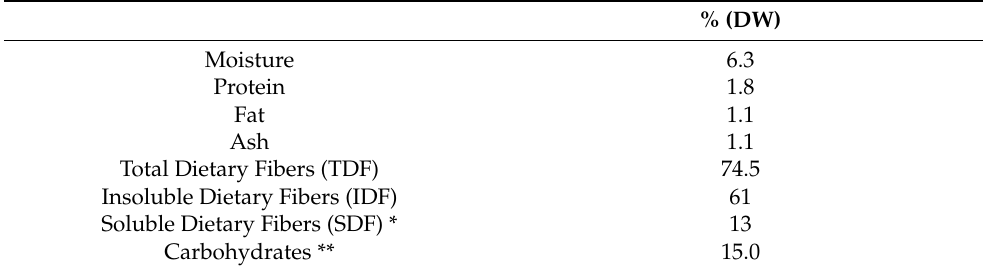
Table 2. Proximate chemical composition of pear pomace flour, on a dry basis (% dry weight (DW)). Values are presented as means ( n = 2). % (DW) Moisture 6.3 Protein 1.8 Fat Ash 1.1 Total Dietary Fibers (TDF) 74.5 Insoluble Dietary Fibers (IDF) 61 Soluble Dietary Fibers (SDF) * 13 Carbohydrates **